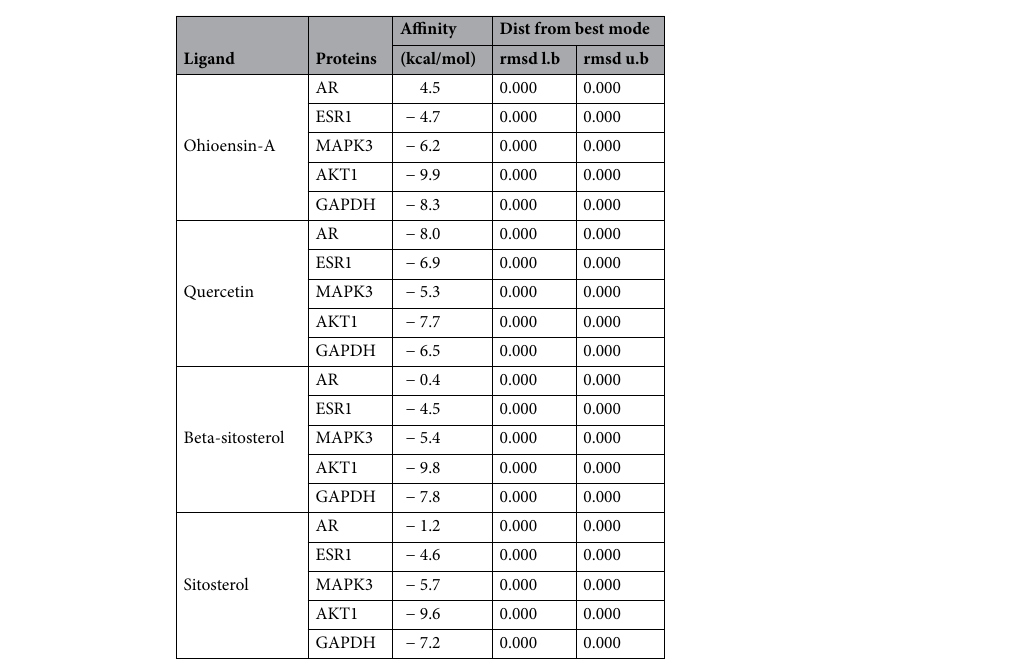
Table 3. The binding energy of molecular docking between the bioactive components and the core predicted